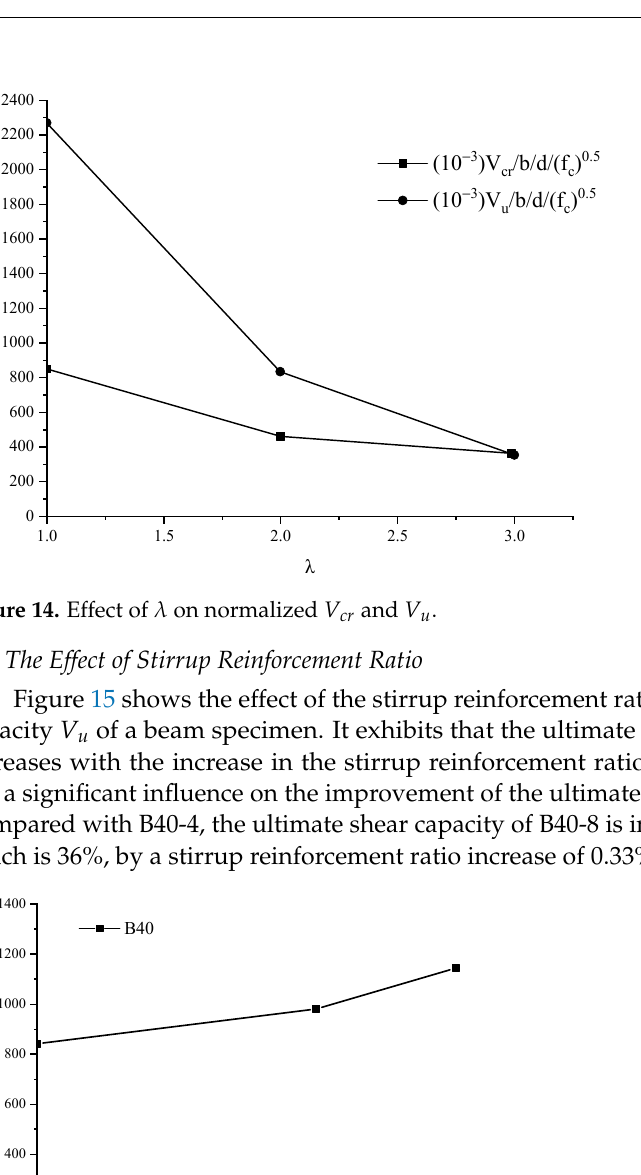
Figure 15. Effect of stirrup reinforcement ratio ρ sv on the normalized ultimate shear capacity V u .